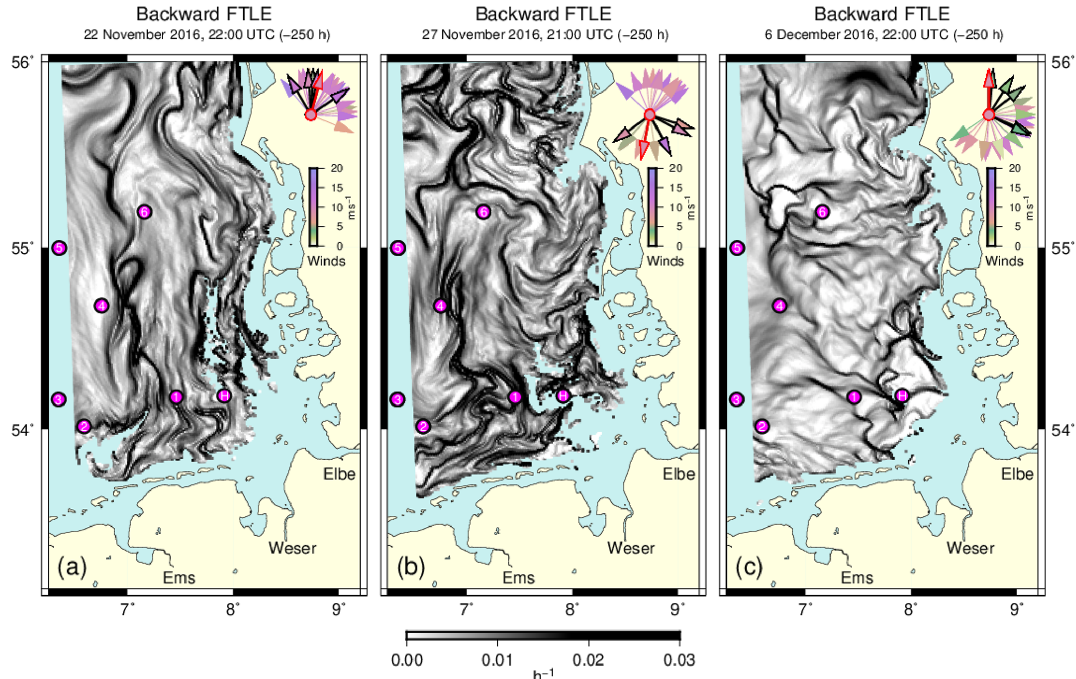
Figure 5. Three backward FTLE fields scheduled with approximately 5d and 9d in between, extracted from a video available in the Sup- plement. Magenta circles indicate the locations of the MARNET stations (1–6) and of the island of Heligoland (H). Vectors in the top-right corners show past wind directions (modelled for the location of station 4) at 10-hourly intervals. Different wind speeds are represented by a colour map. Wind vectors at the times of the plots are outlined in red and those during the last 50h are outlined in